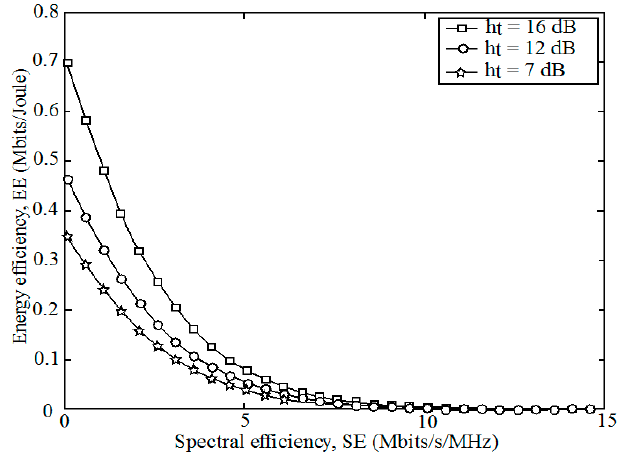
Figure 4. General relationship between SE and EE in a CCRN considering the emission power.